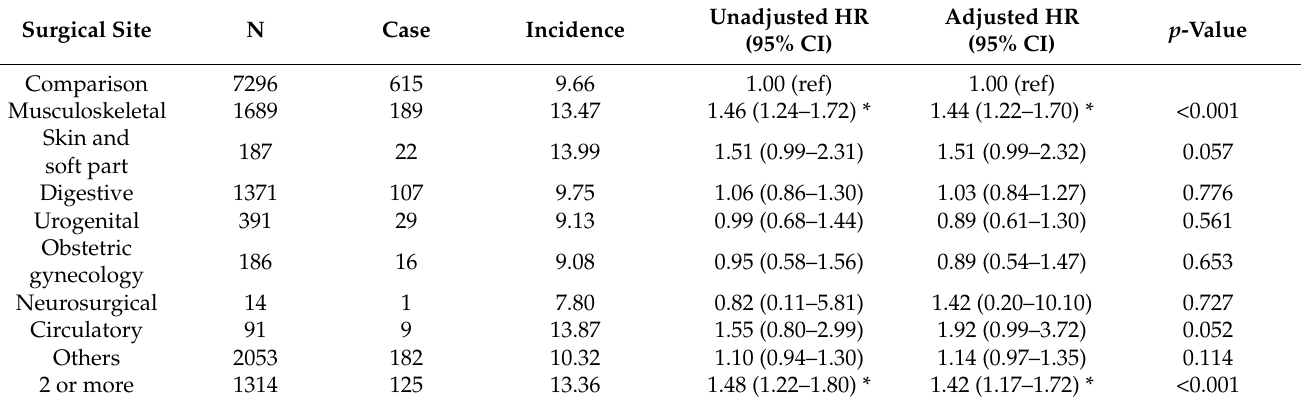
Table 2. Incidence per 1000 person-years and HR (95% CIs) of dementia during the follow-up